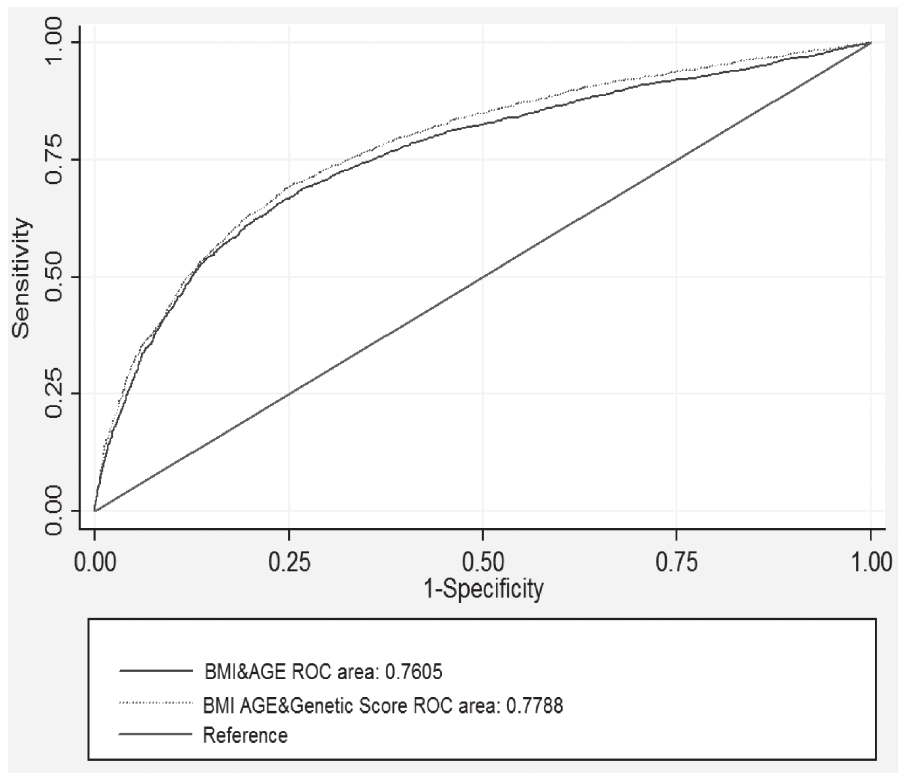
Figure 3. The area under the receiver operating characteristic curves for predicting type 2 diabetes based on 9 single nucleotide polymorphisms, clinical characteristics (age and body mass index). The area under the receiver operating characteristic curve (AUC) for clinical characteristics (age and body mass index) is 0.76 (95%CI: 0.75 – 0.78). When adding the genetic information, it improved to 0.78 (95%CI: 0.77 – 0.79) ( P =